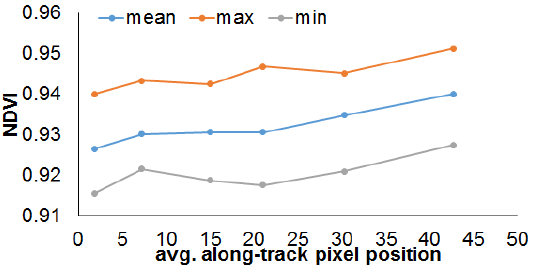
Figure 5 Average (mean), minimum (min) and maximum (max) NDVI values of the image cubes as a function of the average along-track pixel position.